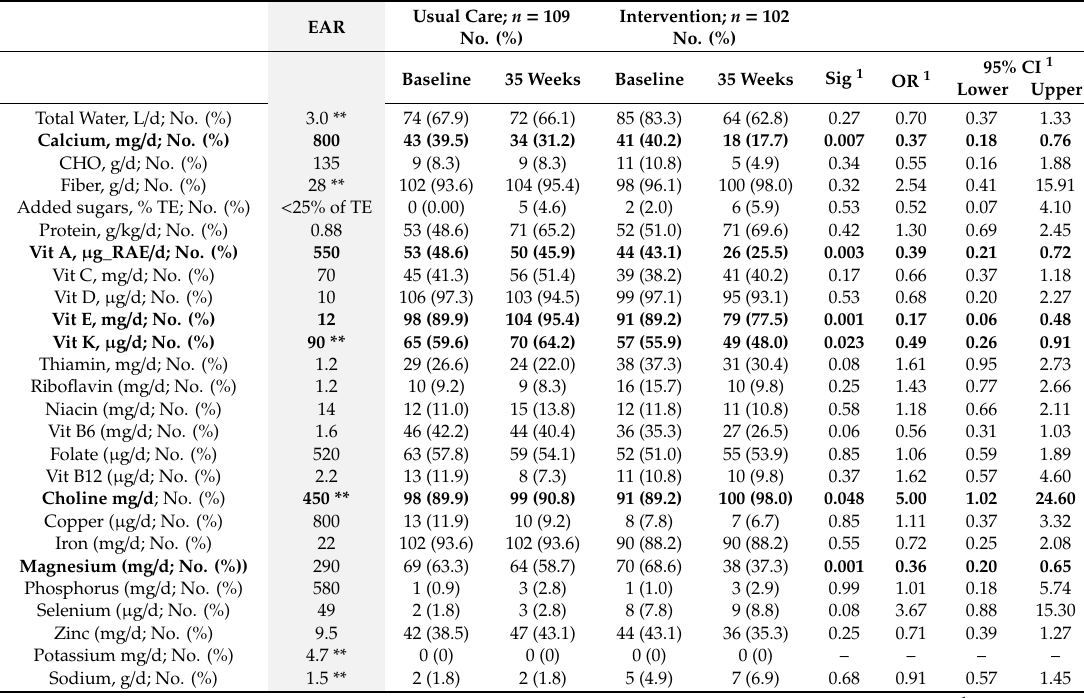
Usual Care; n = 109 Intervention; n = 102 EAR No. (%) No. (%) Baseline 35 Weeks Baseline 35 Weeks Sig 1 OR 1